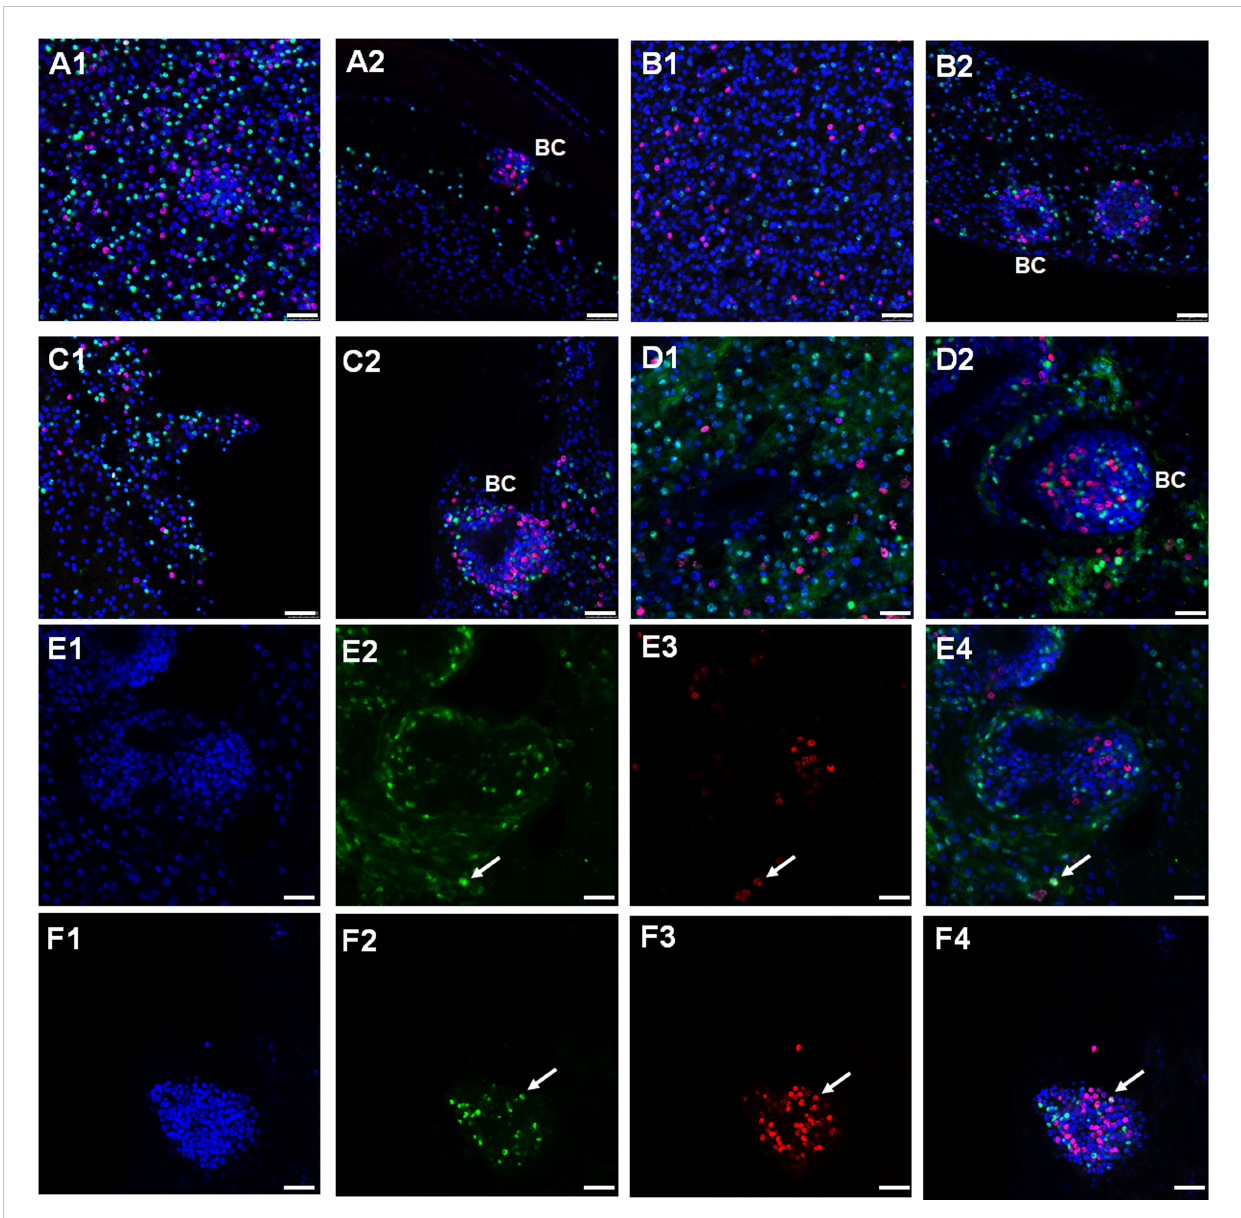
FIGURE 4 Expression of Echinococcus TGF b /BMP receptor encoding genes in germinative layer and BC. Representative WISH images are shown for Emtr1 (A1, A2) , Emtr2 (B1, B2) , Emtr3 (C1, C2) , and Emtr4 (D1, D2) in the germinative layer (A1, B1, C1, D1) and in developing brood capsules (A2, B2, C2, D2) . A to D shows merges of all three channels. Brood capsules are indicated by ‚ BC ’ . Examples of cells positive for EdU and for Emtr4 within the germinative layer (E1 to E4) or brood capsules (F1 to F4) are marked by a white arrow. These images show separate channels for DAPI (nuclei, blue; E1, F1 ), receptor gene probe (green; E2, F2 ), EdU (S-phase, red; E3, F3 ), and a merge of all three channels (E4, F4) . Bar represents 25